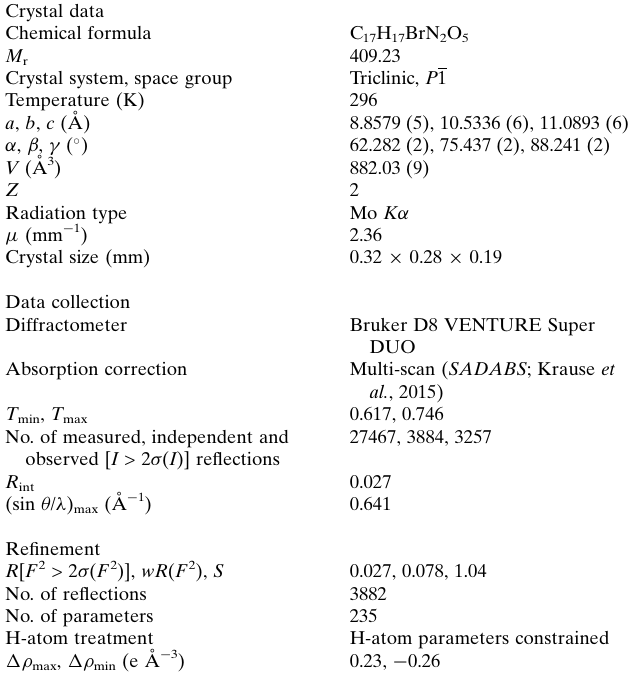
Table 4 Experimental details. Crystal data Chemical